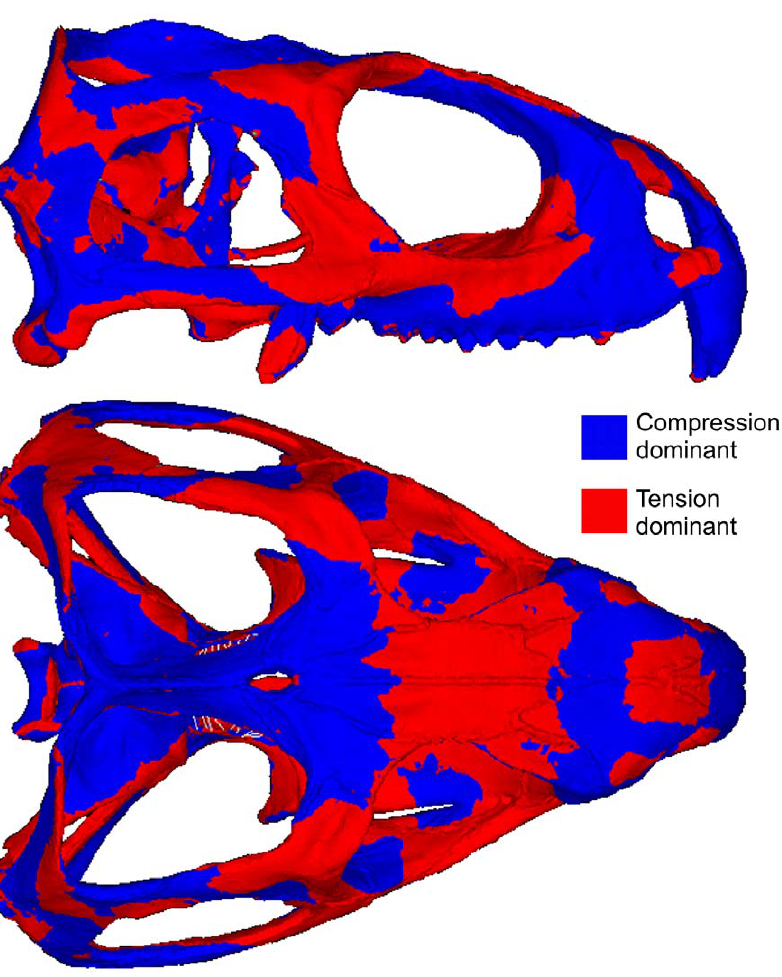
Figure 4. Plot of dominant strain regions. Cumulative map of peak dominant strains over all bites. Red represents regions of the skull where tensile strains are in excess of compressive strains (i.e. tensile strains are dominant), and blue represents regions where compressive strains are in excess of tensile strains (i.e. compressive strains are dominant).